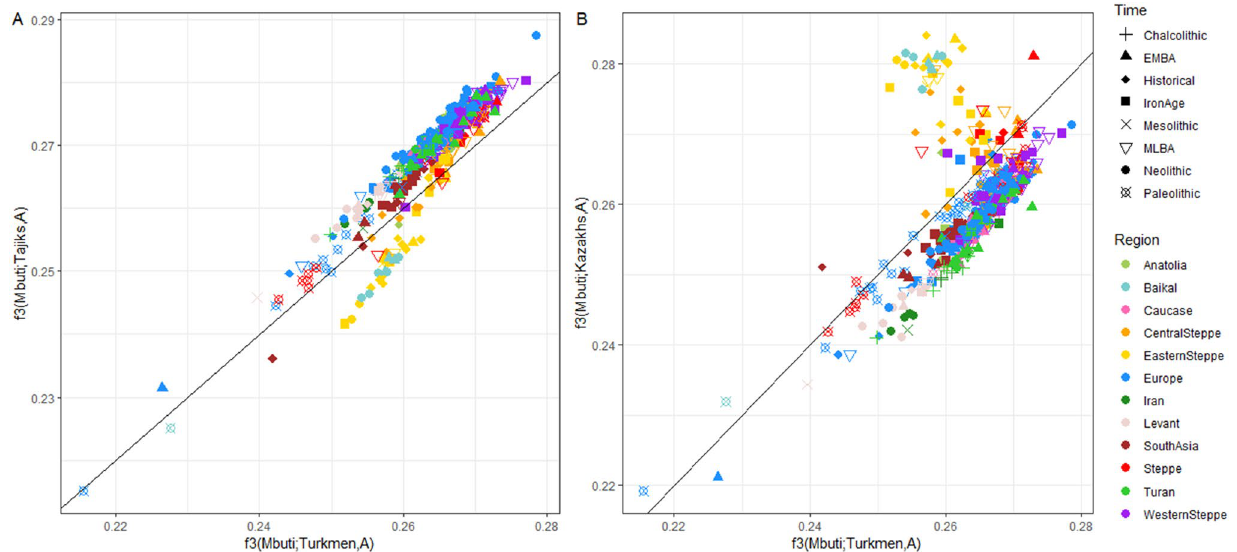
Figure 5. Turkmens’ affinity with Tajiks rather than with Turko-Mongol groups shown by f3 statistics of the form f3(Mbuti; TUR/TJA/AKZ , Ancient population ). ( A ) Outgroup f3-statistics for Turkmen and for Tajiks (TJA) plotted against each other. ( B ) Outgroup f3-statistics for Turkmen and for Kazakhs (AKZ), belonging to the Turko-Mongol group, plotted against each other. (Figure done with ggplot2 v. 3.3.3 R package https:// cran.r- proje ct. org/ web/ packa ges/ ggplo t2/ index.